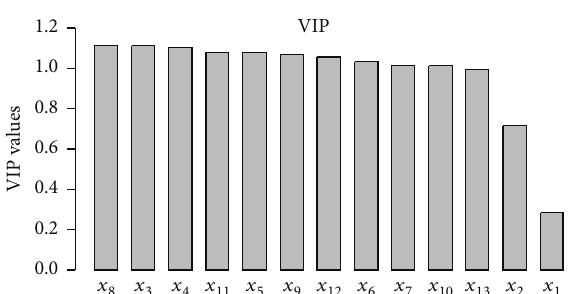
Figure 5: (a) 𝑡 1 /𝑢 1 scatter graph. (b) 𝑡 1 /𝑡 2 oval graph.